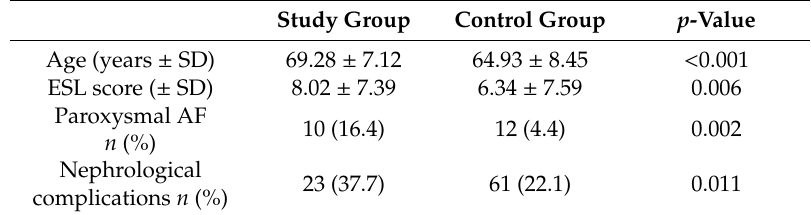
Table 7. Factors predisposing to the occurrence of AF with concomitant SVT. Study